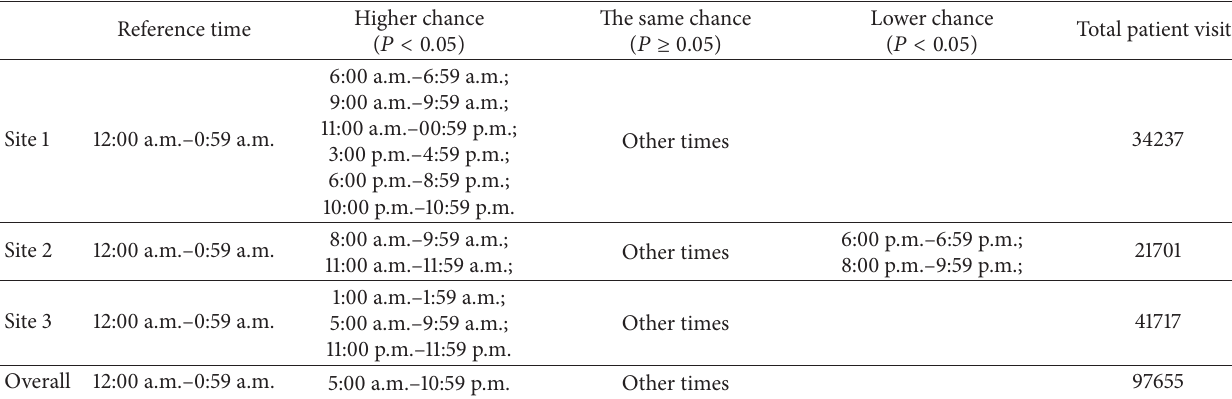
Table 2: Adjusted odds ratio of HIV testing by hour of patient arrival in the ED categorized by site. Reference